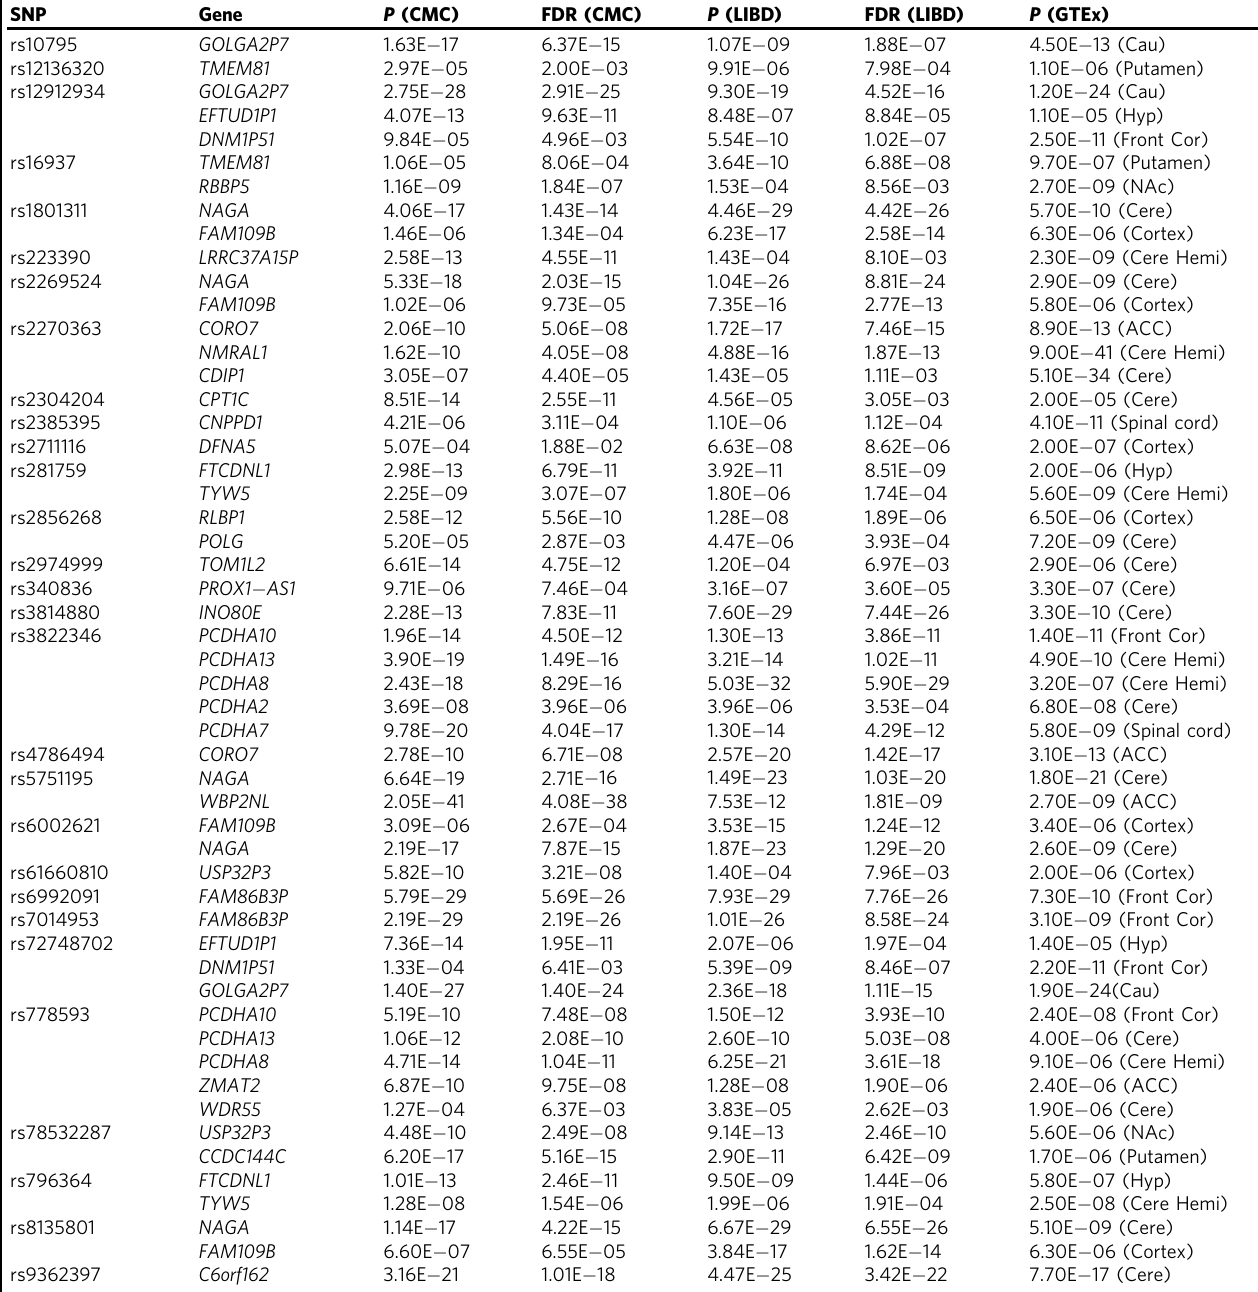
Table 1 Association signi fi cance between the TF binding – disrupting SNPs and gene expression in human brain tissues SNP